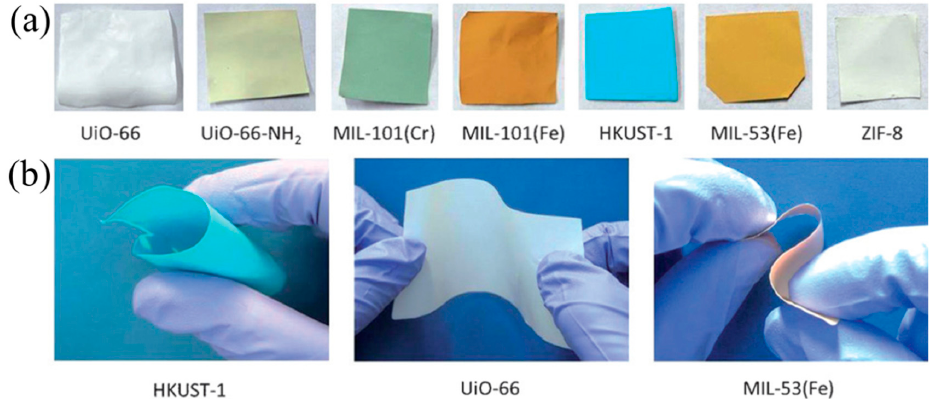
Figure 9. ( a ) Free-standing mixed matrix membranes (MMMs, ≈ 1 × 1 cm 2 ) produced from a variety of MOFs; ( b ) Flexibility of large-area HKUST-1, UiO-66, and MIL-53(Fe) MMMs ( ≈ 3 × 5 cm 2 ). Reprinted with permission from Reference [87]. Copyright 2015 WILEY-VCH Verlag GmbH & Co.